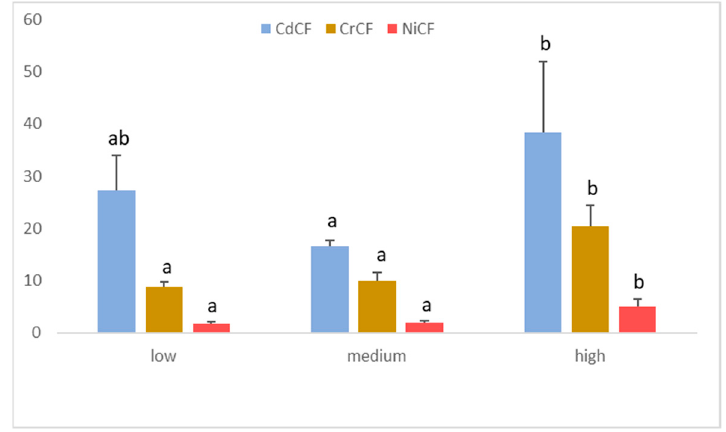
Figure 4. Variation of Contamination Factor (CF) as a function of traffic density (low, medium, and high) for Cd, Cr, and Ni. Different lower ‐ case letters indicate a significance difference among levels of traffic density for specific heavy metals (CdCF; Duncan p = 0.044, CrCF; Tukey p = 0.002, and NiCF, Tukey p = 0.003).